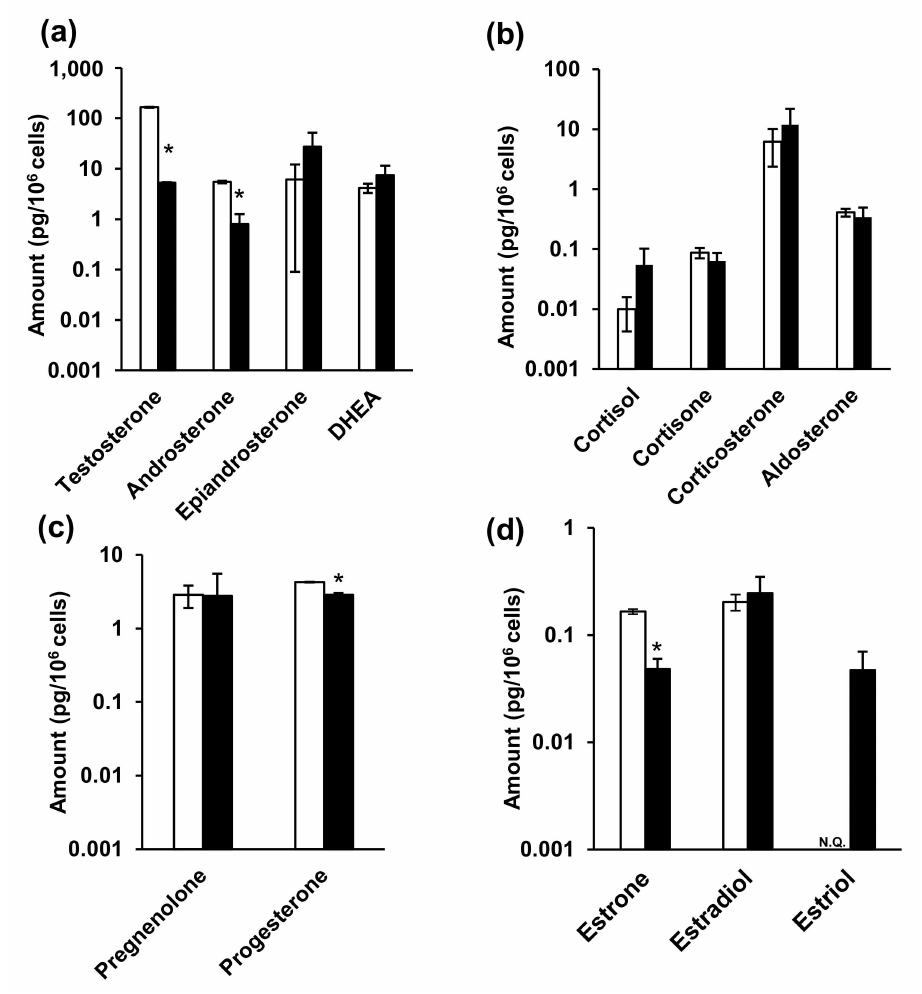
Figure 4. The amounts of steroid hormones in the cells. ( a ) Androgens, ( b ) glucocorticoids and mineralocorticoid, ( c ) progestins, and ( d ) estrogens. White and black bars indicate wild-type and NPC model cells, respectively. * indicates significant differences observed using Wilcoxon’s test ( p < 0.05). NPC, Niemann–Pick disease type C; N.Q., not